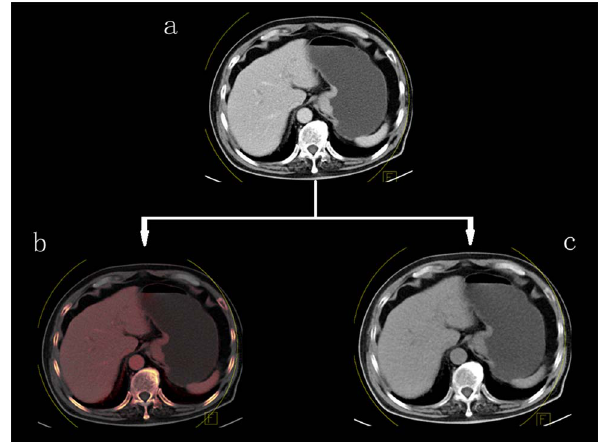
Figure 1. Dual-energy data post-processing. a Dual-energy portal venous phase image, b fused image of virtual 120-kV data sets with the color map of iodine distribution, c virtual non-enhanced image after iodine